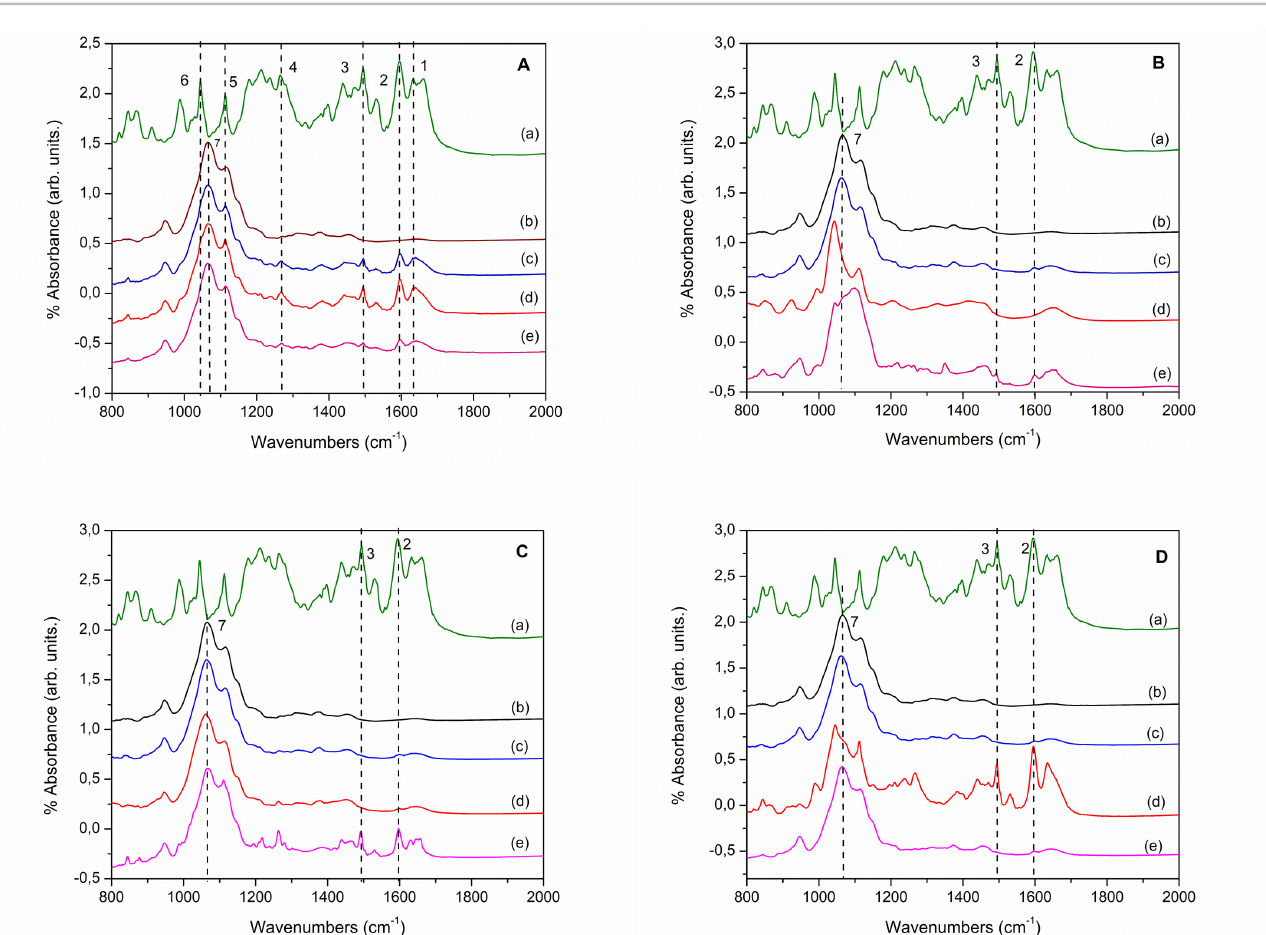
FIGURE 1 - Fourier transformed infrared (FTIR) spectra of panel (A): doxazosin mesylate (DOX) (a), hydroxypropyl methylcellulose (HPMC) E6 (b), without plasticizer (WP)-F1 (c), WP-F4 (d), and WP-F7 (e); panel (B): DOX (a), HPMC E6 (b), F2 (c), F1 (d), and F3 (e); panel (C): DOX (a), HPMC E6 (b), F5 (c), F4 (d), and F6 (e); and panel (D): DOX (a), HPMC E6 (b),